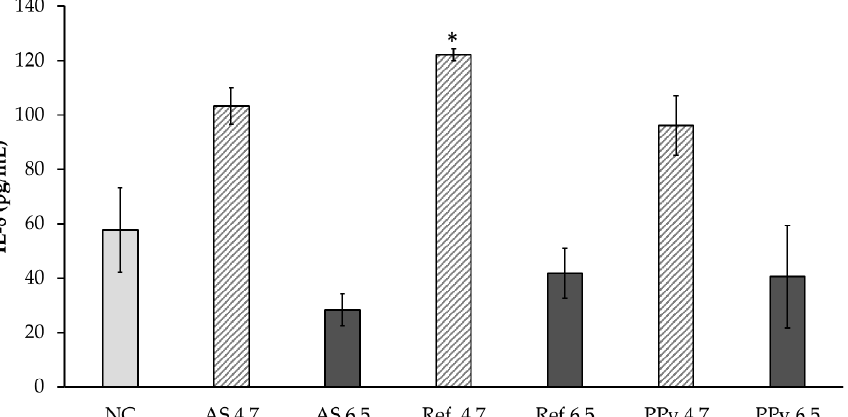
Figure 9. Release of IL-8 after 18 h of exposure of EpiDerm ™ to textile extracts obtained from PPy-coated textiles extracted for 72 h at 37 °C in AS at pH 4.7 and 6.5. NC: negative control (PBS 1X); AS: artificial sweat solution; Ref: reference material (fabric without NPs). * p < 0.05; One-way ANOVA + Bonferroni’s, statistically different compared to negative control sample.